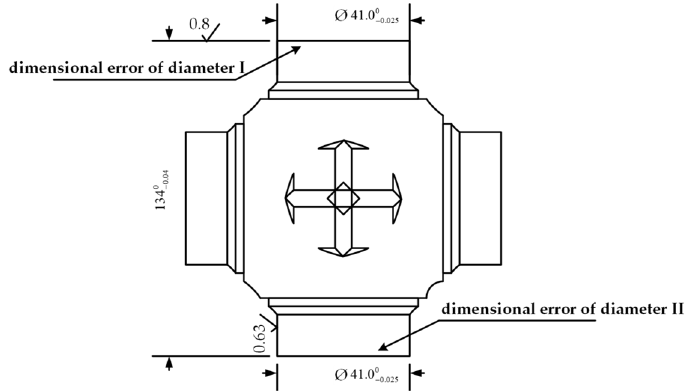
Figure 6. Drawing of heavy cross axis.